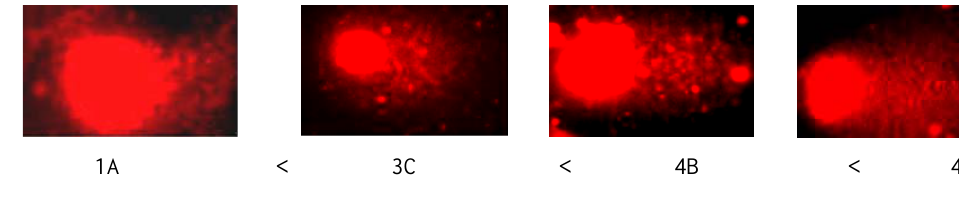
Figure 7. Visual scoring of the Comet test on ACNA soil